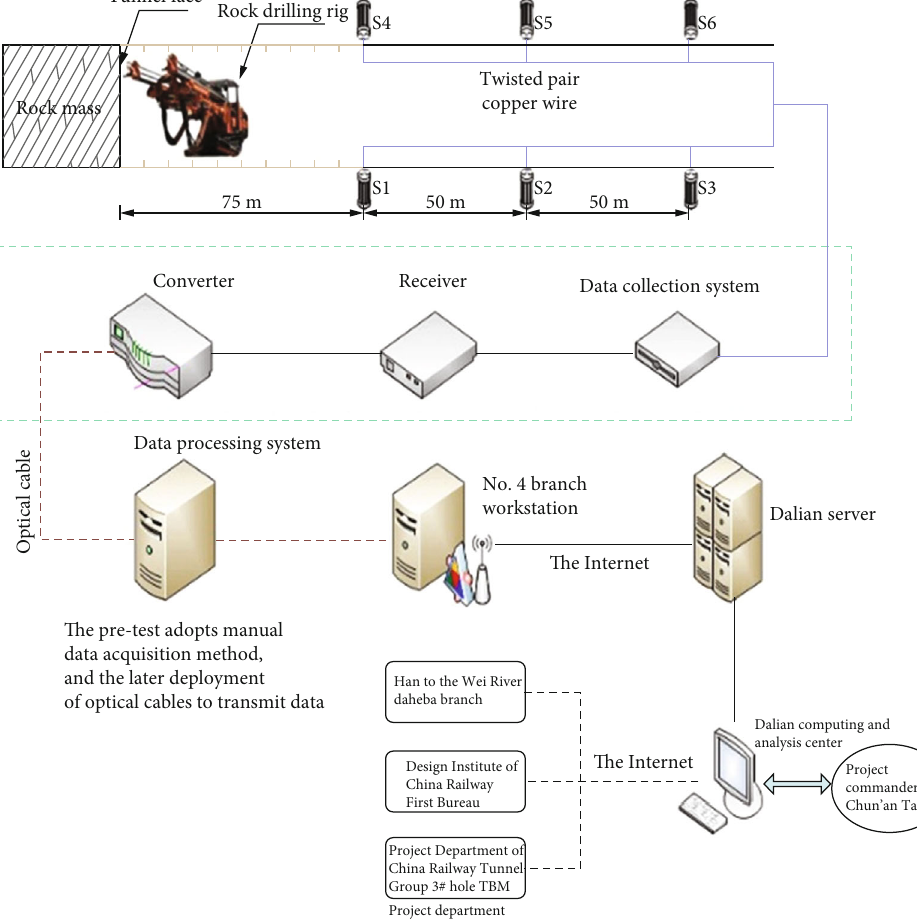
Figure 20: A complete network schematic of sensor layout and data acquisition, transmission, and processing of the microseismic monitoring system in the Han to the Wei River Qinling tunnel no. 4, Shanxi province.